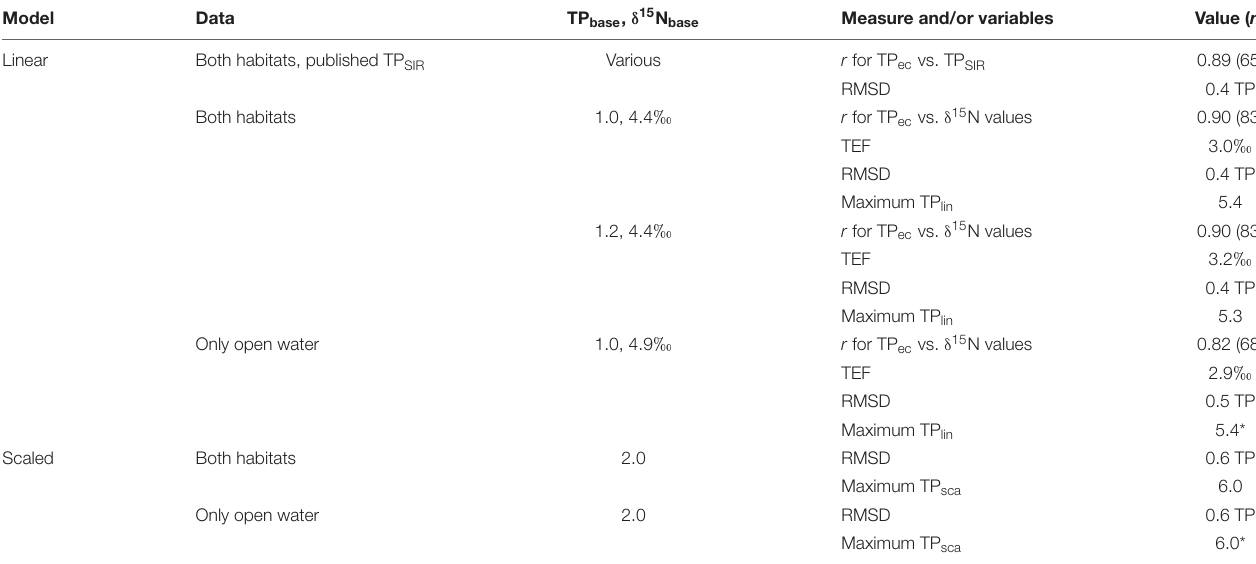
TABLE 3 | Overview of major results from comparison of trophic positions from Ecopath and calculation of trophic positions using fixed fractionation (linear model) and scaled fractionation.